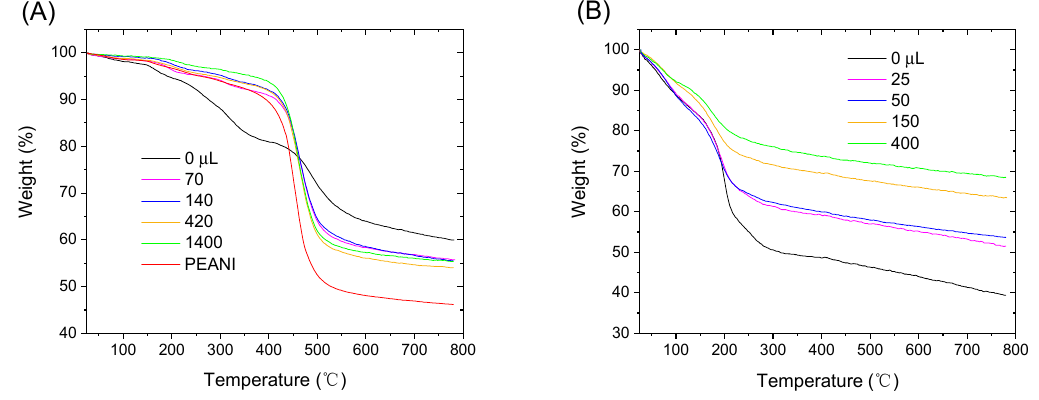
Figure 4. Thermogravity analysis (TGA) curves of ( A ) PEANI / GO and PEANI / rGO obtained by reduction with di ff erent amounts of hydrazine; ( B ) pure GO and rGO obtained by reduction with different amounts of hydrazine. TGA curves of pure PEANI are shown in ( A ).